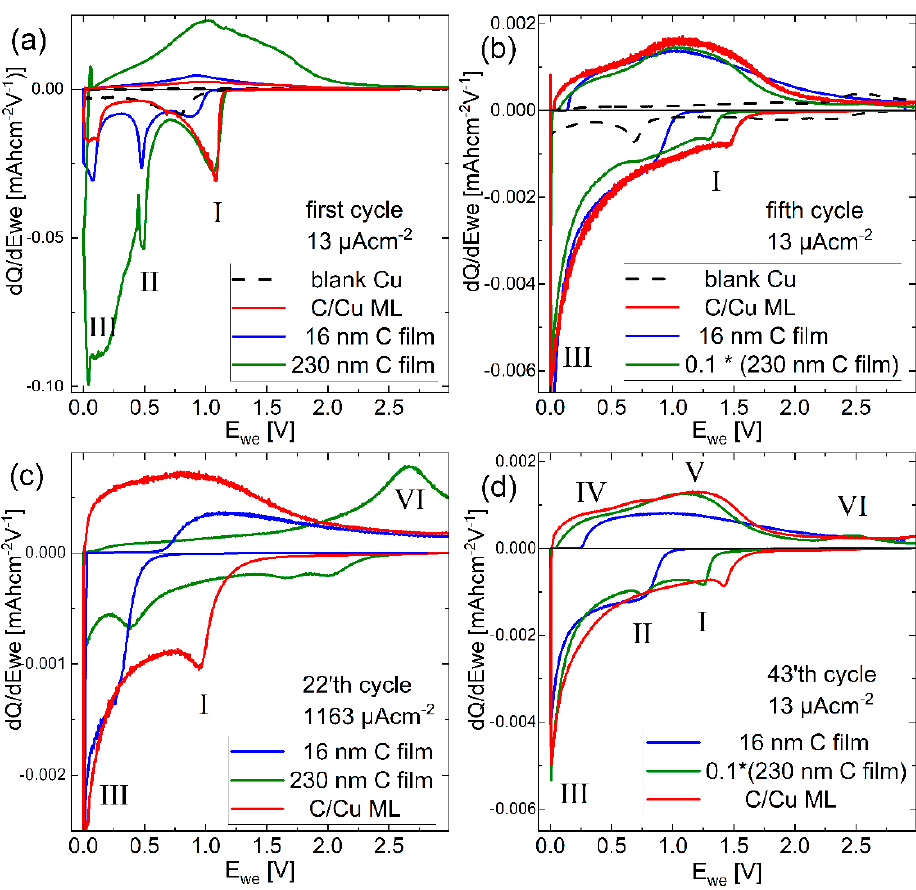
Figure 8. Differential charge (dQ/dV) curves for the rate capability experiments (Figures 3 and 4) of the C/Cu ML (red curves), 16 nm (blue curve), and 230 nm (green curve) carbon single-films, and the blank copper electrode (dashed line). ( a ) first, ( b ) fifth, ( d ) 43 cycles at 13 µAcm − 2 , and ( c ) of the 22 cycles at 1163 µAcm − 2 . For better visualization, the intensity for the 230 nm C film is multiplied by 0.1 in ( b , d ). A color version of this figure can be viewed online.